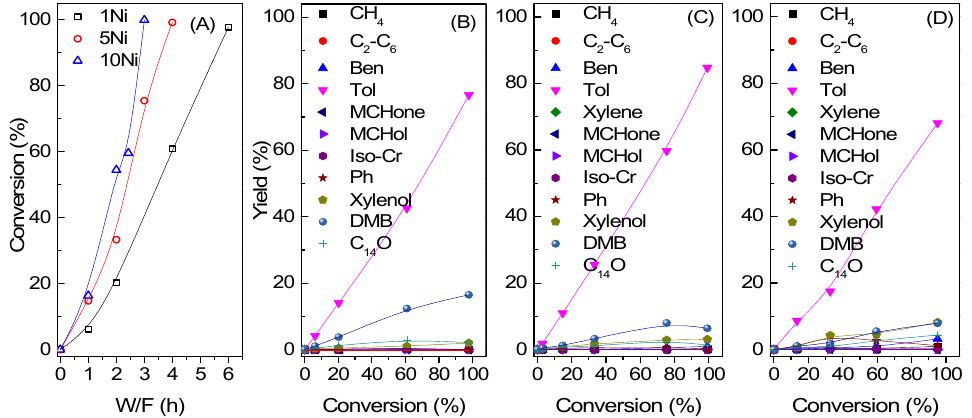
Figure 8. Conversion rate as a function of W/F ( A ) and product yields with change in conversion over ( B ) 1Ni/r-TiO 2 , ( C ) 5Ni/r-TiO 2 , and ( D ) 10Ni/r-TiO 2 . Reaction conditions: T=350 °C, P = 1 atm, H 2 /m-cresol = 50, TOS = 30 min. Ben, Tol, MCHone, MCHol, Iso-Cr, Ph, DMB, and C 14 O represent benzene, toluene, methylcyclohexanone, methylcyclohexanol, cresol isomers, phenol, dimethylbiphenyl, and 5,5 ´ -dimethyl-3-hydroxybiphenyl, respectively.